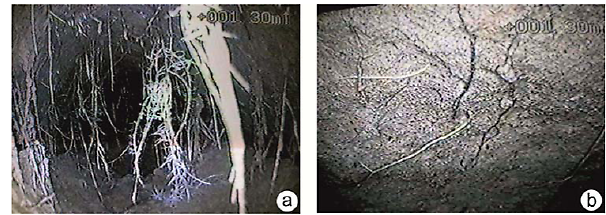
Fig. 12. Video still shot images (courtesy of Capannori Municipal- ity). (A) internal part of horizontal tunnel; (B) detail of tunnel vault in which fractures, roots and micro-holes are recognizable.